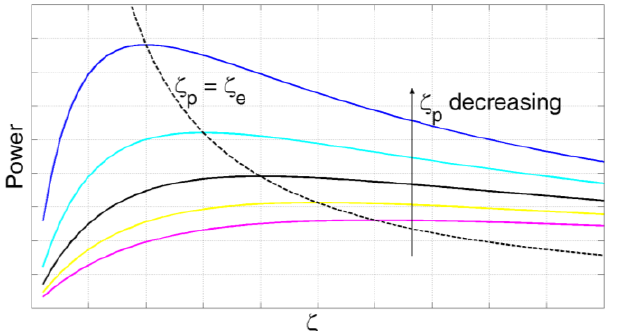
Figure 7. Power of the piezoelectric generator as a function of the electrical damping ratio. The black dashed line is obtained from Equation (12) by imposing . For a given mechanical damping, the maximum extracted power is achieved when the electrical damping equals the mechanical